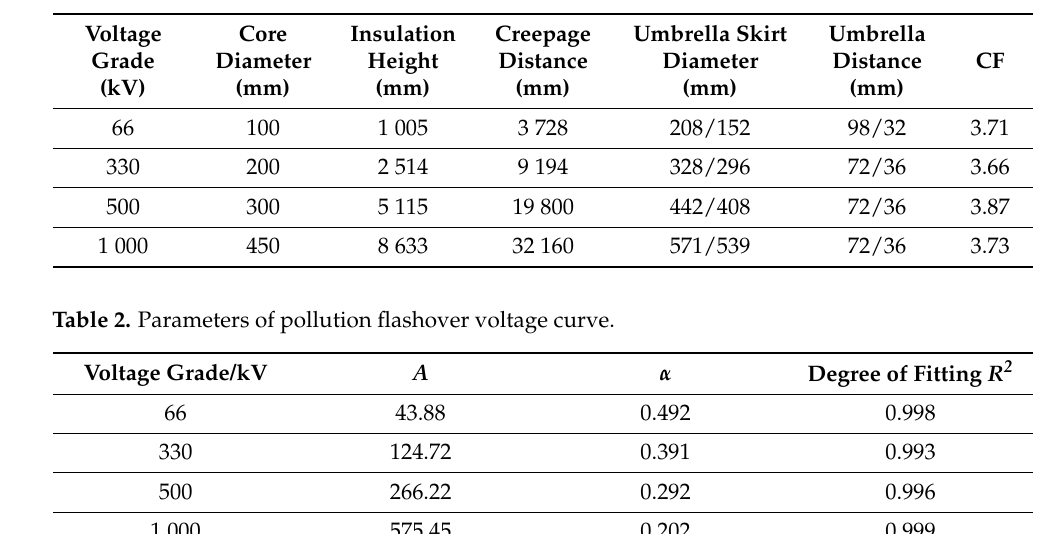
Figure 2. Sample arrangement. Table 1. Composite crossarm insulator parameters. Figure 1. Schematic of sample structure.